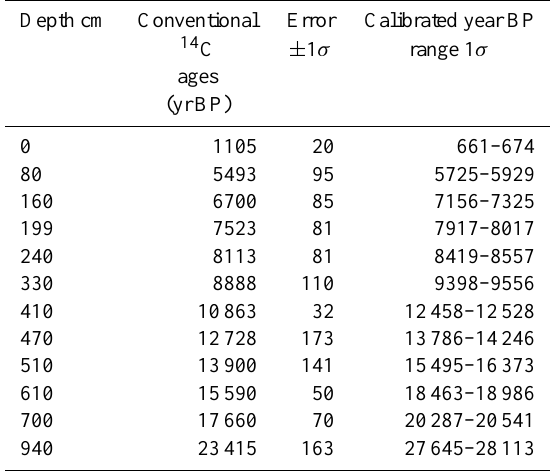
Table 1. Depth-age model for the MD04-2797. Dates were cali- brated using CALIB 6.0.